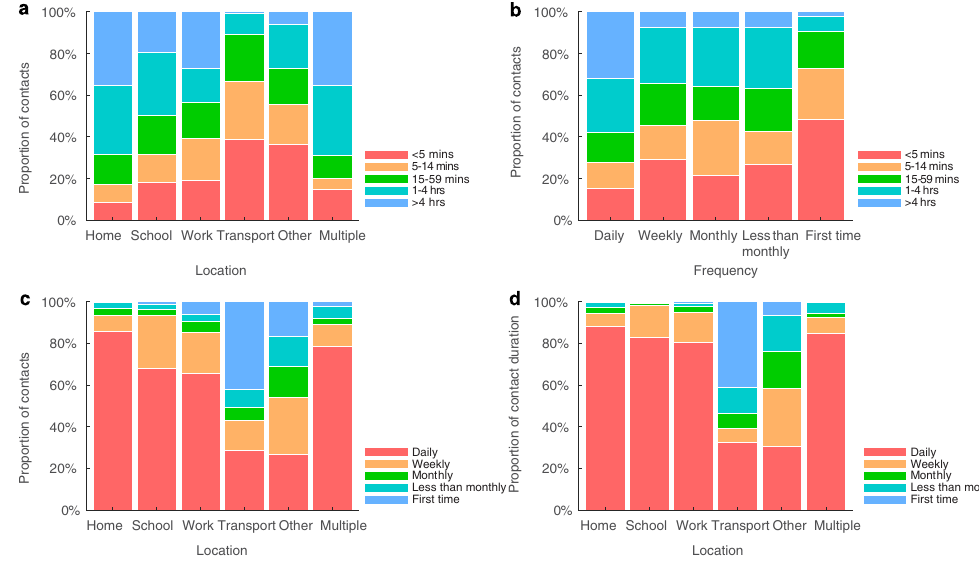
Figure 4. The correlation between contact duration, location and frequency. The correlation between ( a ) duration and location, ( b ) duration and frequency, and ( c , d ) location and frequency of